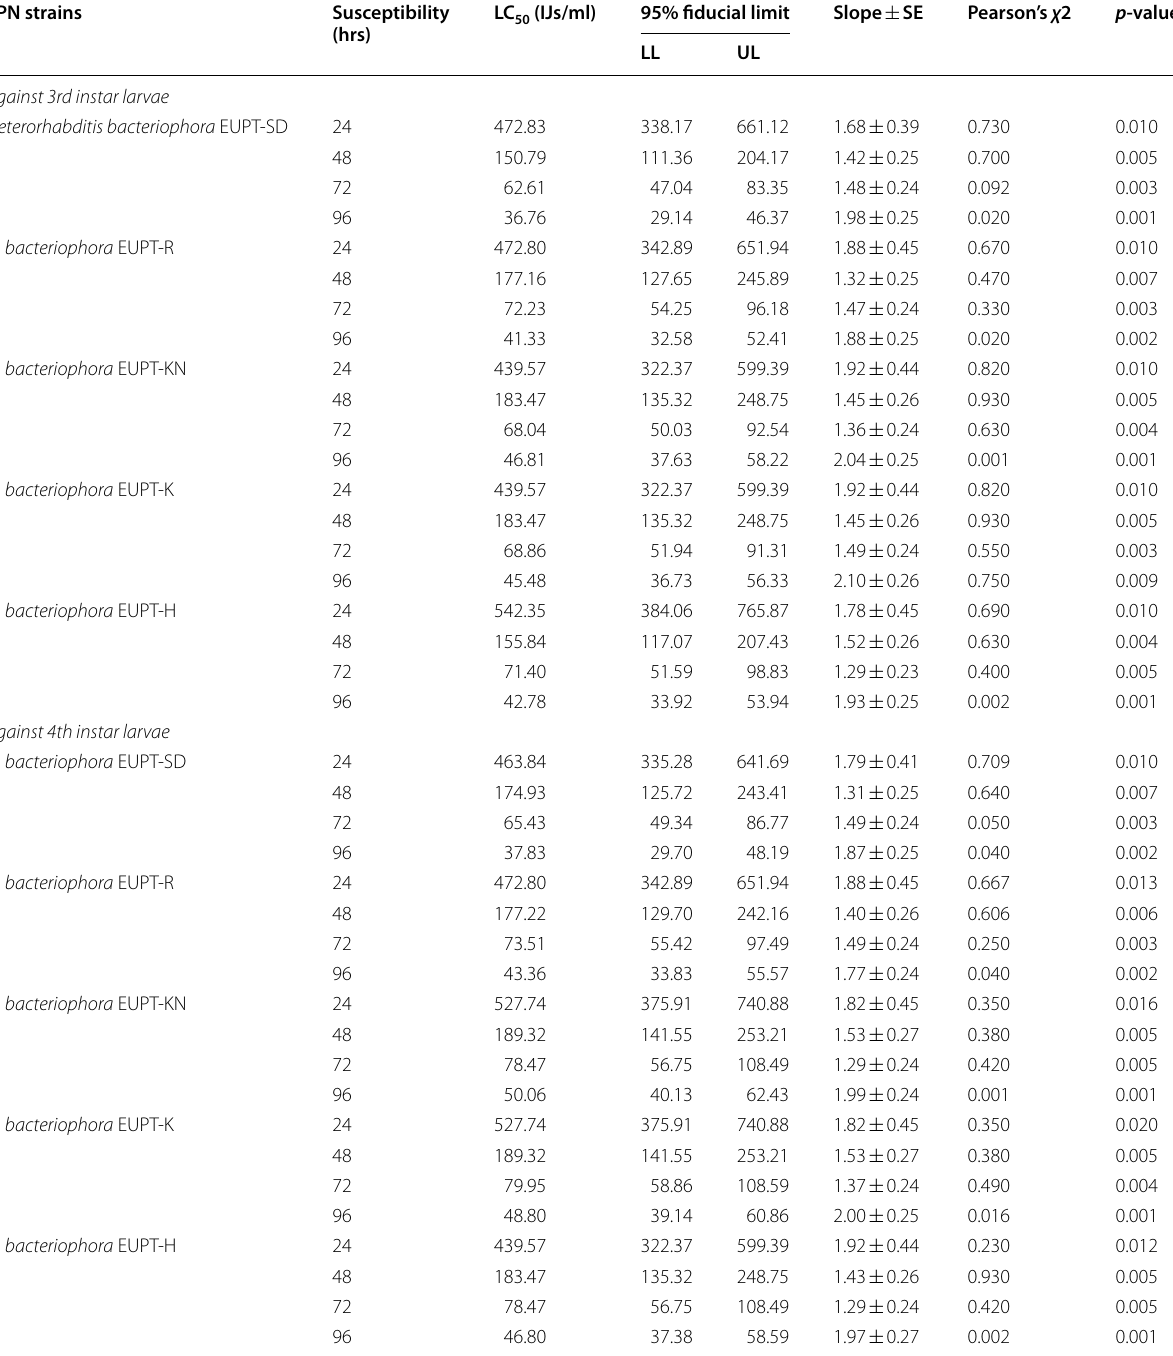
Table 1 Log probit analysis for the assessment of mortality in 3rd and 4th larval instars of the tobacco cutworm, Spodoptera litura by different entomopathogenic nematode strains